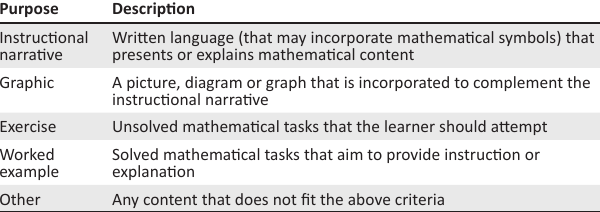
TABLE 1: The different purposes of textbook content used to partition the selected chapters.